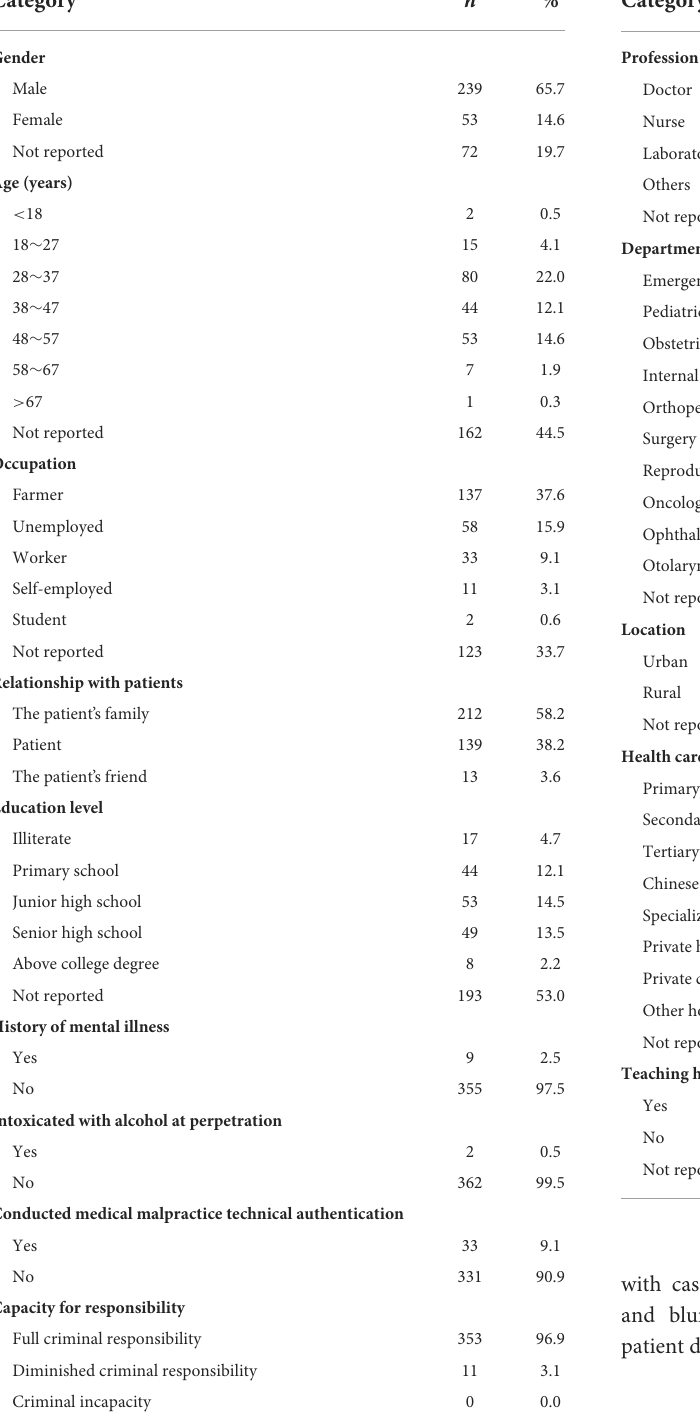
(Table 3). By contrast, hanging banners, blocking hospital passages, placing flower wreaths, burning paper money and placing the corpse in the hospital were significantly